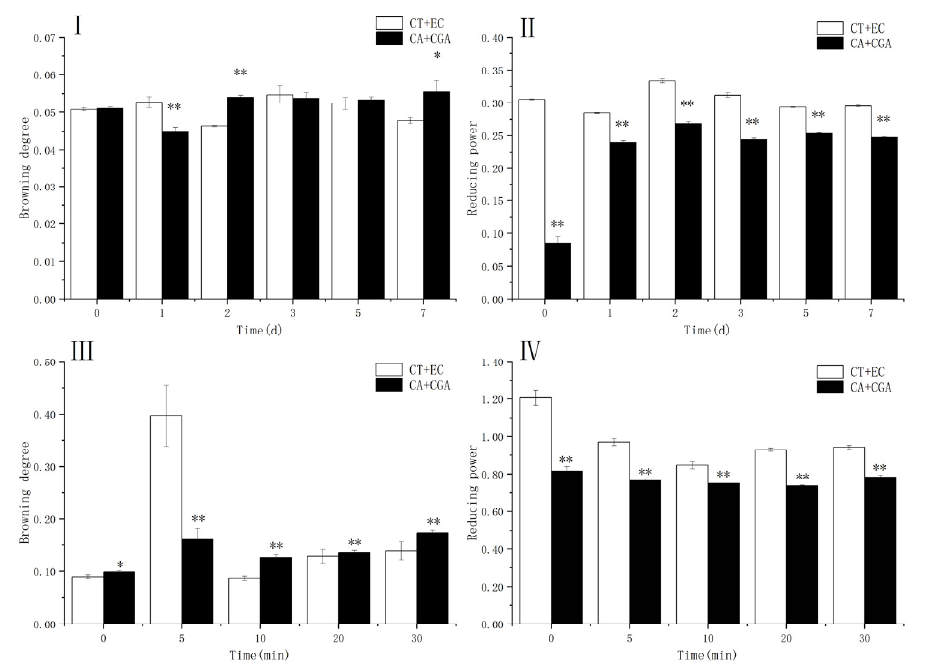
Figure 8. The browning degree and reducing power of ( I, II ) autoxidation and ( III, IV )